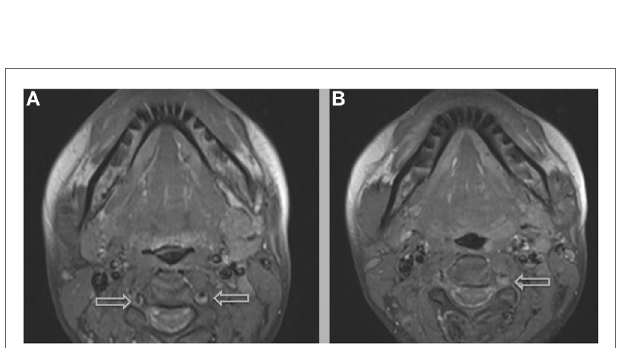
FIgURe 6 | Additional MRI imaging indicating mural hematomas within the right (a,B) and left (B) vertebral arteries, findings that would resolve following anticoagulant therapy and the cessation of lenvatinib.